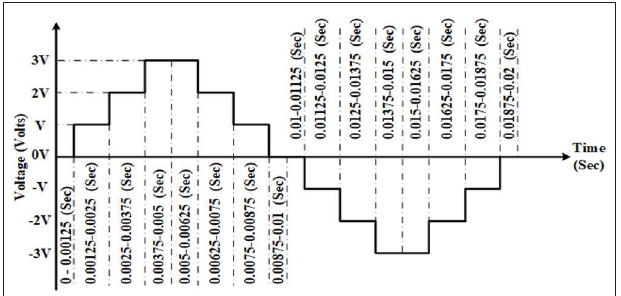
FIGURE 3 | Time distribution of one cycle for seven-level